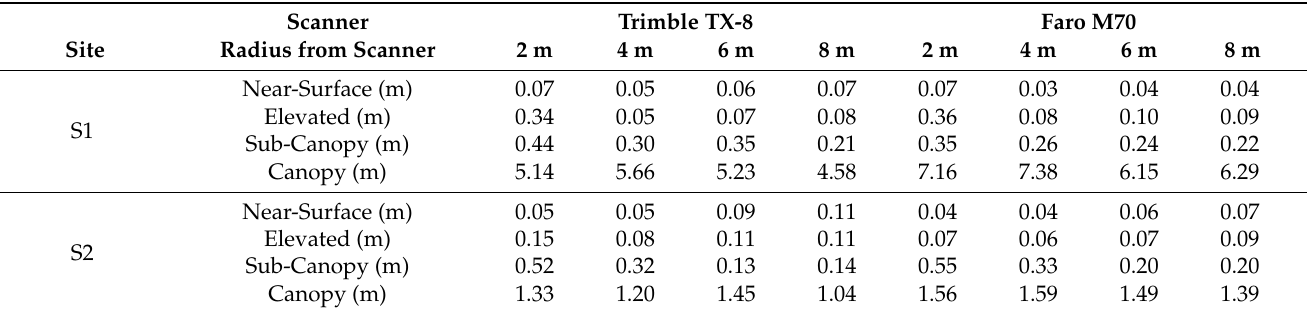
Table 4. RMSE of fuel layer height estimates from single scan data in comparison to the estimates derived from reference 3D model for the same